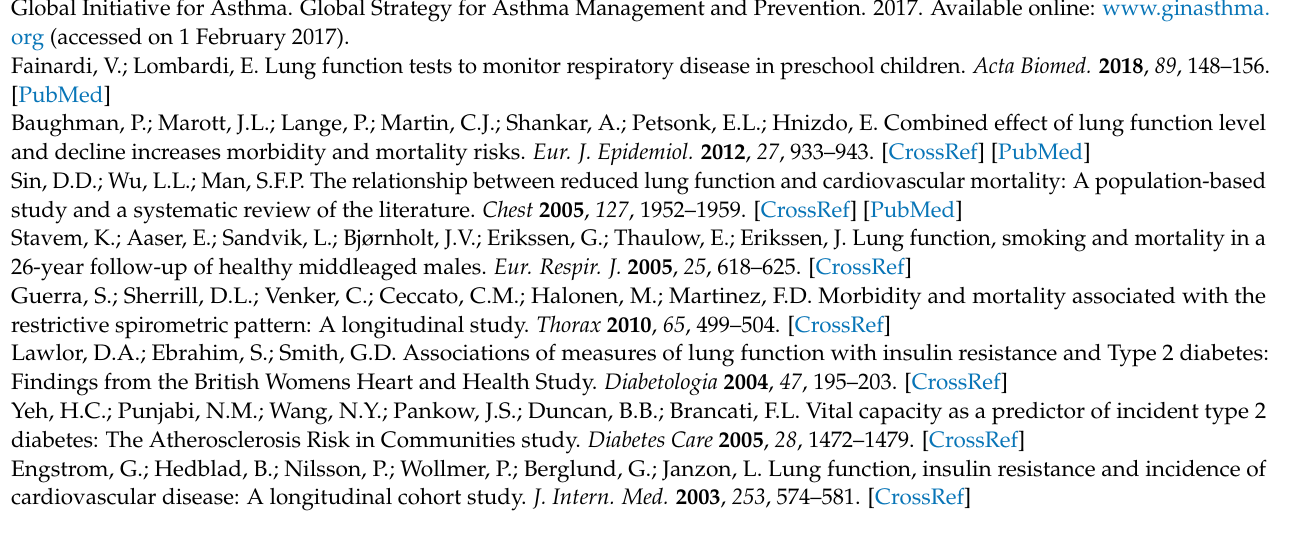
styles; Figure S2: Concentrations of six main pollutants in different seasons of Wuhan, China; Table S1: Anthropometry, sociodemographic, household and parental information and children’s behavior patterns by residence location (urban versus suburban); Table S2: Prevalence of reduced lung function in children with different gender and areas, and the odds ratios (OR) and 95% confidence interval (95% CI) of the prevalence of reduced lung function in children in male versus female; Table S3: Lung function and the prevalence of impaired lung function in children with different BMI status, bold numbers were statistically significant; Table S4: Adjusted odds ratios (OR) of impaired lung function in relation to different BMI in children, bold numbers were statistically significant; Table S5: Prevalence of reduced lung function in children with different potential influence factors; Table S6: Adjusted OR (95% CI) for decreased lung function and opening window, using air condition in different seasons for children from urban and rural areas ( n = 383); Table S7: Rate of preterm birth, household renovation, doing physical exercise of children among mother groups being different